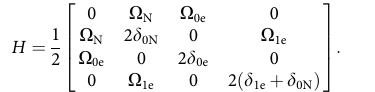
Sensor and memory . Correlation measurement in general . We use the electron spin as a sensor for magnetic fields and the nitrogen nuclear spin as an insensitive storage qubit. In the manuscript, the quantum wire diagram for the correlation measurement sequence with variable entanglement is displayed (see Fig. 1c orange